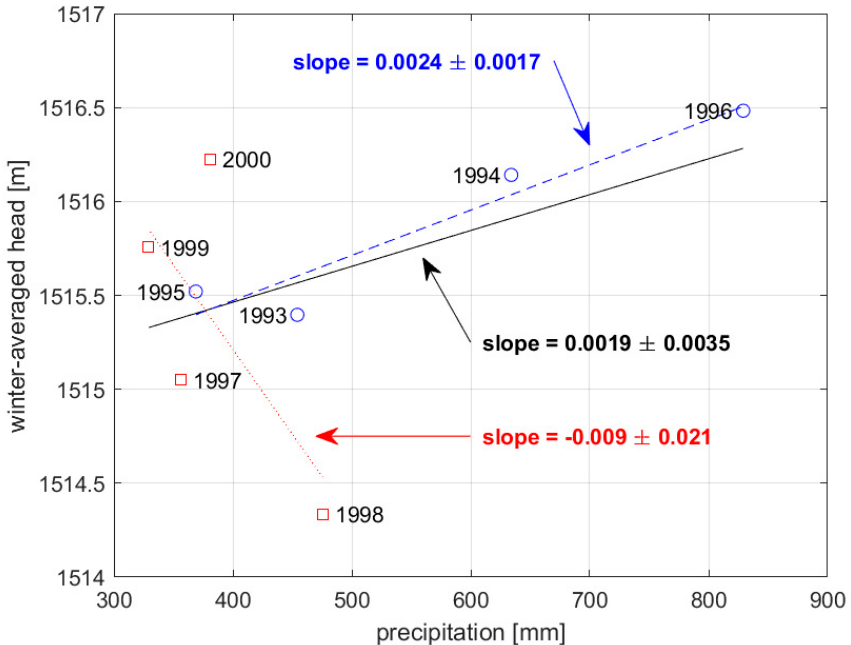
Figure 7. Winter-averaged groundwater level versus annual precipitation each 1 February. The correlation for all eight years (1993–2000) is a black solid line; the correlation for pre-wildfire years (1993–1996) is a blue dashed line; the correlation for post-wildfire years (1996–2000) is a red dotted line. Each slope is reported as a 95% confidence interval using the t-test with 7 degrees of freedom when n = 8 and with 3 degrees of freedom when n = 4. Only the pre-fire correlation is significant.